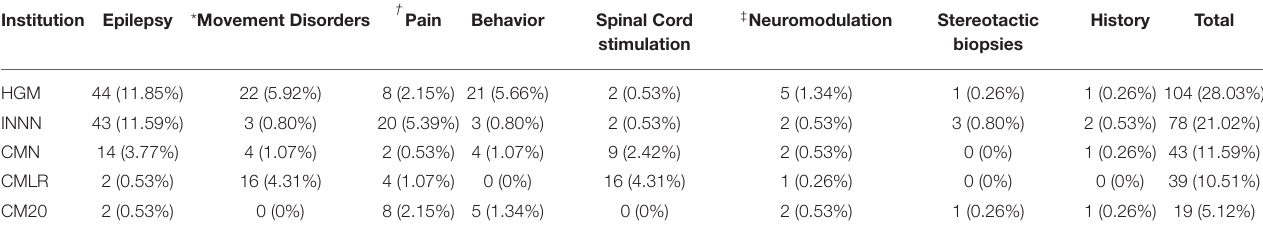
TABLE 2 | Neurosurgery Department’s production by subject of research.